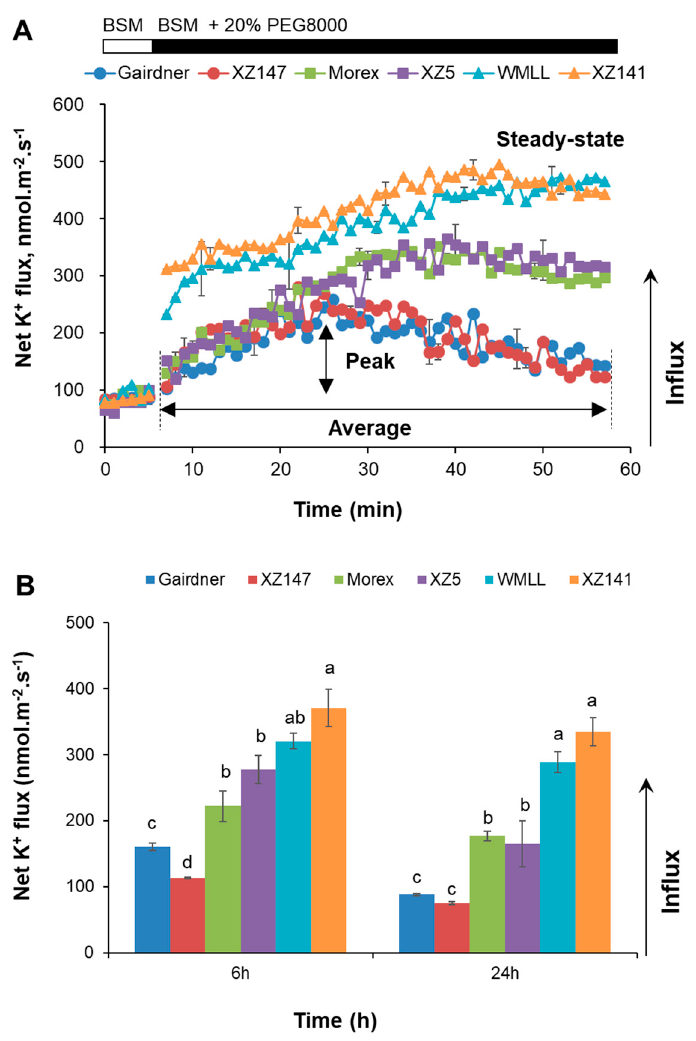
Figure 6. Transient ( A ) and steady-state ( B ) net K + flux response to drought stress generated by 20% PEG8000 measured from mature ( ∼ 20 mm from root tip) zones of six barley varieties contrasting in drought stress tolerance. Data are mean ± SE ( n = 6 individual plants). The onset of treatment is indicated by an arrow. Measurements were undertaken at room temperature (24 ± 1 °C). Different lowercase letters indicate the significant di ff erence between genotypes at p < 0.01.